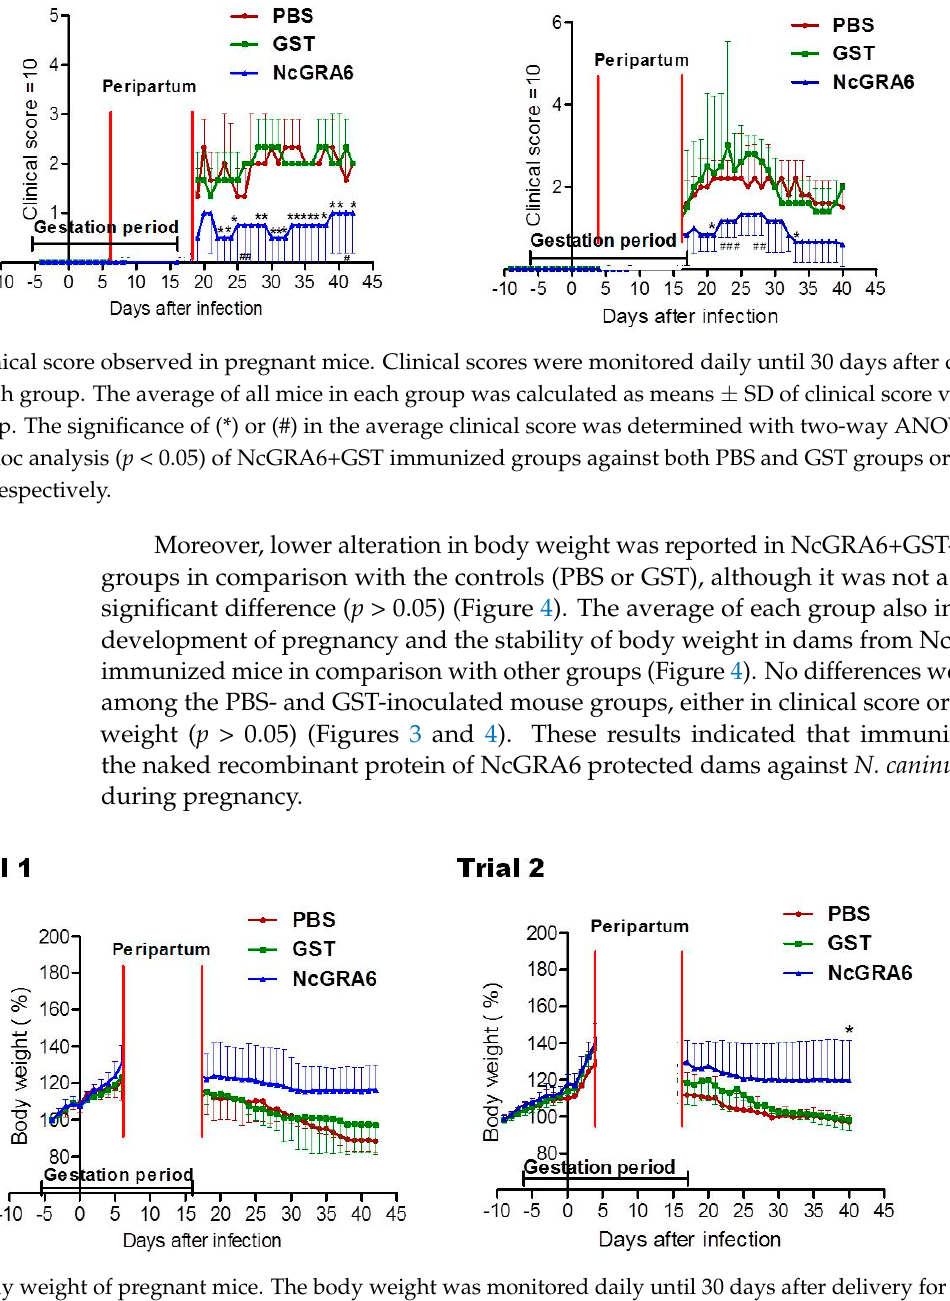
Figure 4. The body weight of pregnant mice. The body weight was monitored daily until 30 days after delivery for all mice in each group. The average of all mice in each group was calculated as means ± SD of body weight values of all adult mice in a group. No significant difference was observed in the body weight (two-way ANOVA and Bonferroni posttest, p > 0.05). Pregnancy in all mice was confirmed by visible vaginal plug associated with remarkable increase in body weight (increase in body weight by > 20% than that at the day of confirmation of vaginal plug).